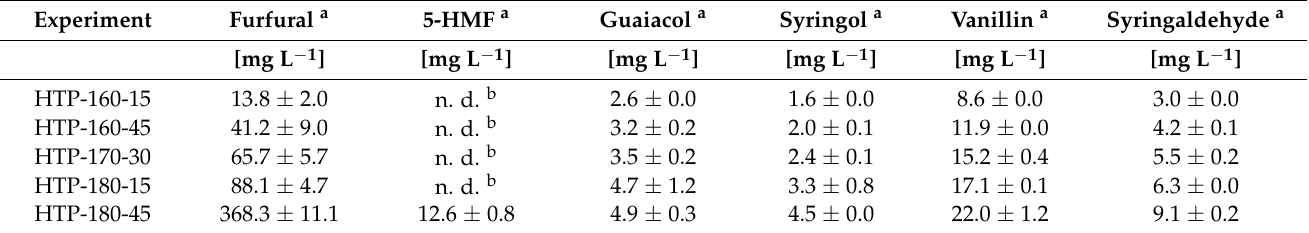
Table 4. Content of soluble organic fractions in process water under different hydrothermal pretreat- ment conditions considering furanic and phenolic compounds.